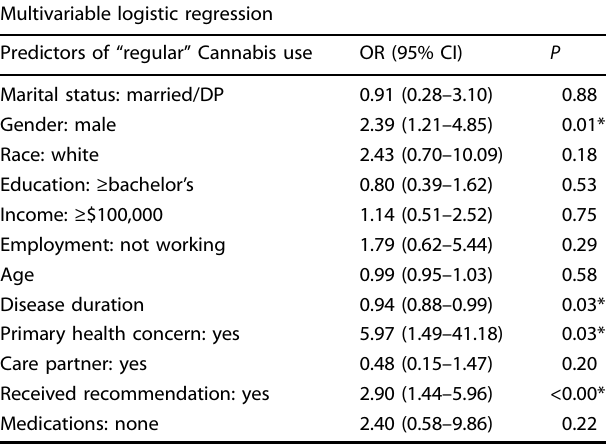
Table 4. Adjusted analysis of “ regular ” Cannabis use. Multivariable logistic regression